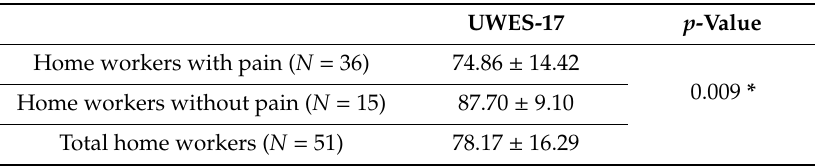
Table 7. Job satisfaction assessment.